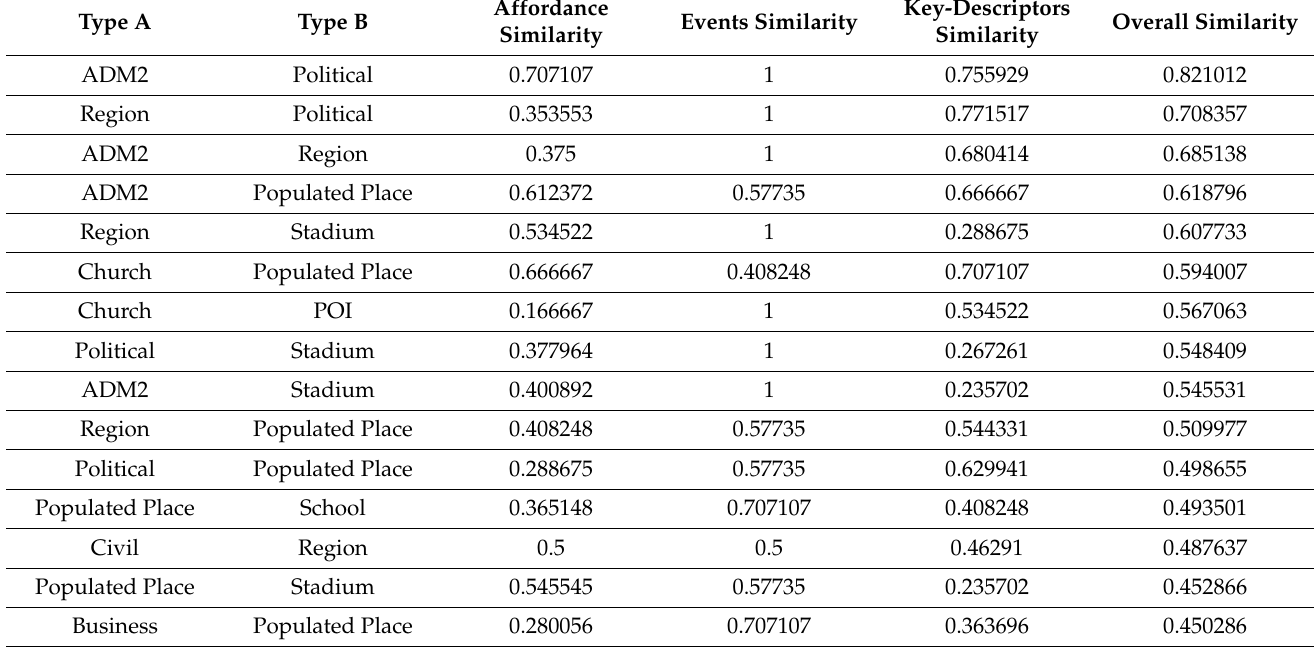
Figure 4. Cosine similarities between place categories by individual factors: place affordances ( top left ), key-descriptors ( top right ), and events ( bottom ). Table 4. Overall similarity scores for distinct place categories, with the individual similarity scores for three factors.